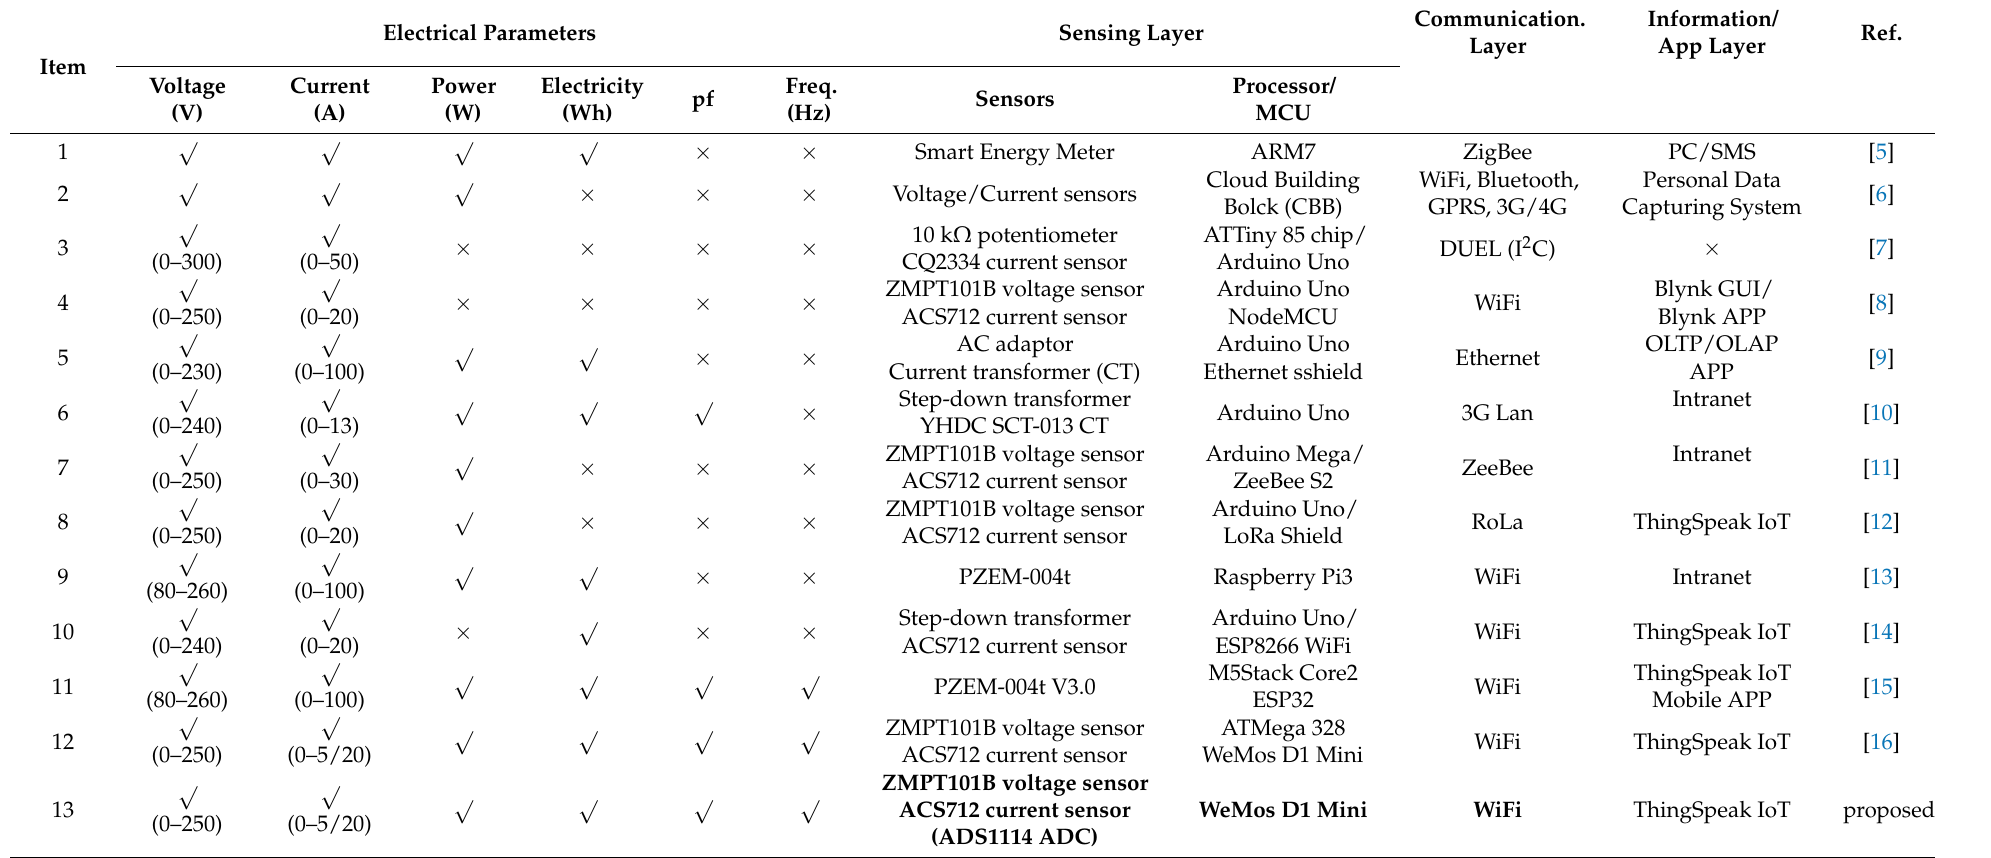
Table 1. Comparisons for AC power monitoring